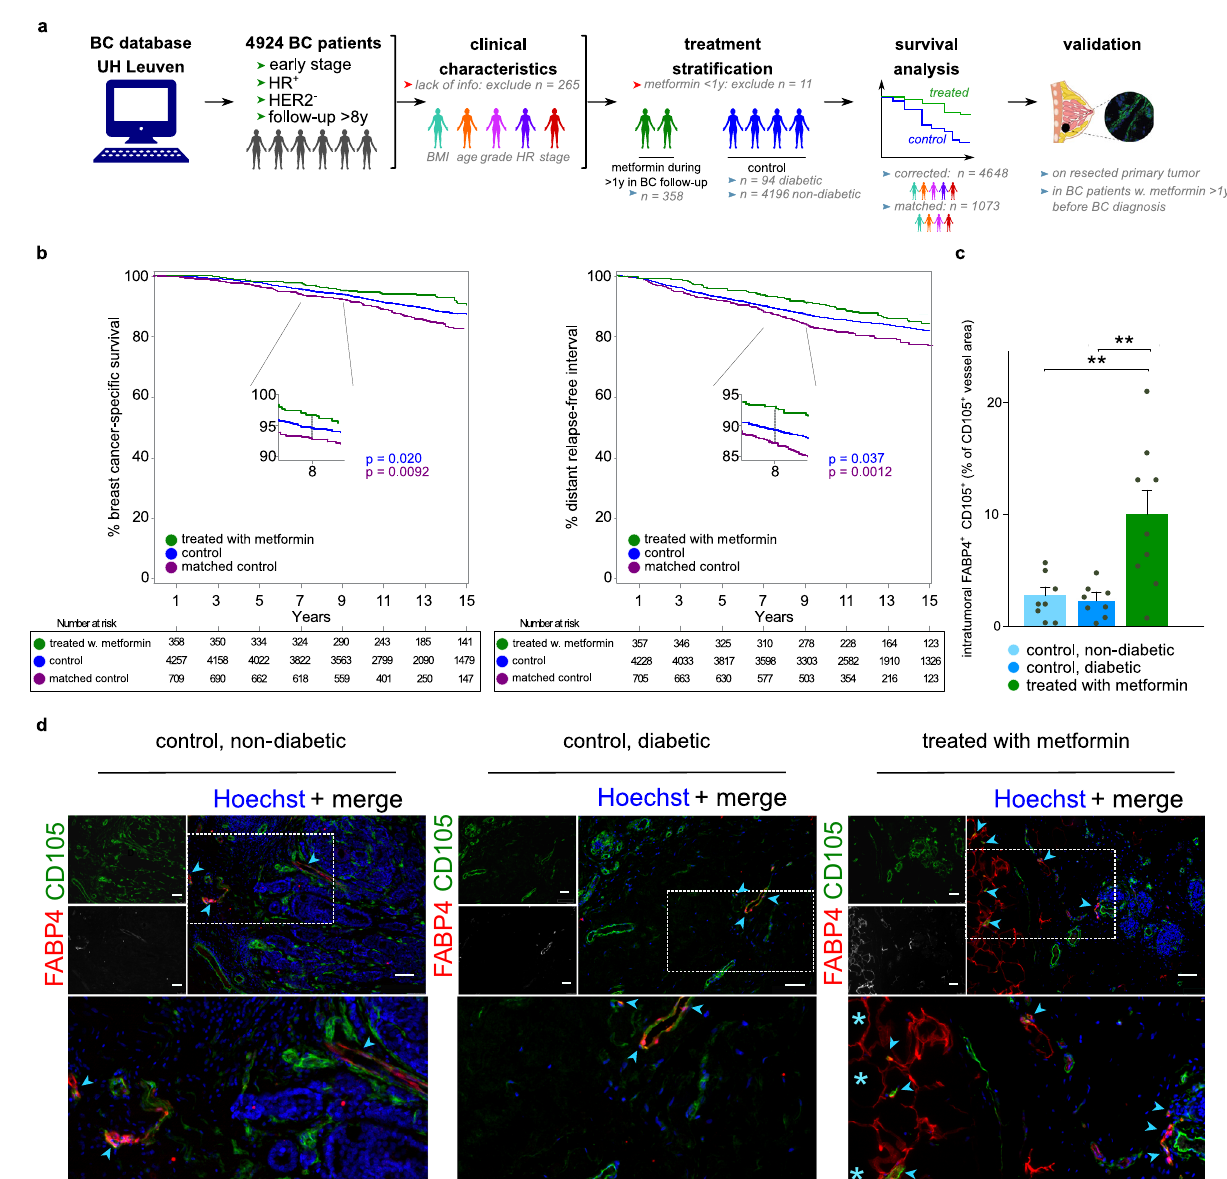
patients; purple for matched control patients). Numbers in the boxes underneath the curves depict the number of patients per group that are at risk for the event (mortality in left panel, mortality/development of metastasis in right panel) at the indicated time points. c Quanti fi cation of FABP4 + blood vessels (% area of total CD105 + blood vessels) in non-diabetic BC patients ( n =8) and in diabetic patients without( n =8)orwith( n =9)metformintreatment.Dataaremean±SEM,** p <0.01 (exact p -values = 0.0030 and 0.0023, respectively), one-way ANOVA followed by Dunnett ’ s multiple comparisons test. d Representative micrographs of human breasttumortissuesectionsincontrolnon-diabetic(left; n =8)ordiabetic(middle; n =8) control BC patients and in (diabetic) BC patients treated with metformin (right; n =9), immunostained for CD105, FABP4 and counterstained with Hoechst. Arrowheads denote CD105 + FABP4 + vessels, asterisks denote (putative) adipocytes, which (besides LIPECs) are also positive for FABP4. Brightness was increased line- arly (gamma=1) to improve visibility for CD105 and FABP4. Scale bar: 75 µ